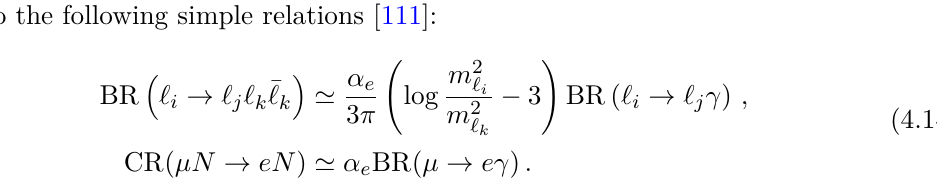
Figure 4 . The contour plot of BR( µ → eγ ) in the τ plane for m 0 = M The value of branching ratio is normalized with the current upper bound 4 . 2 × 10 − 13 [115]. The other free parameters are fixed to their best-fit values as given in eq. (3.7), where the best-fit value of h τ i is marked by a green pentagram in the